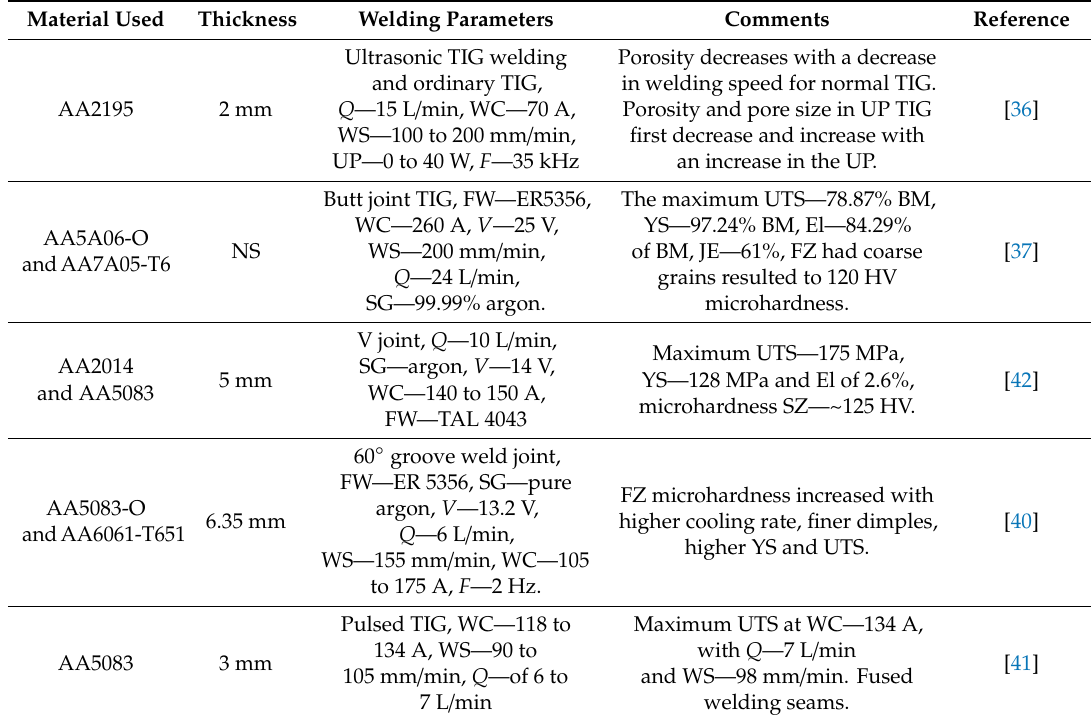
Table 2. TIG welding of dissimilar materials / alloys. (WC—welding current, WS—welding